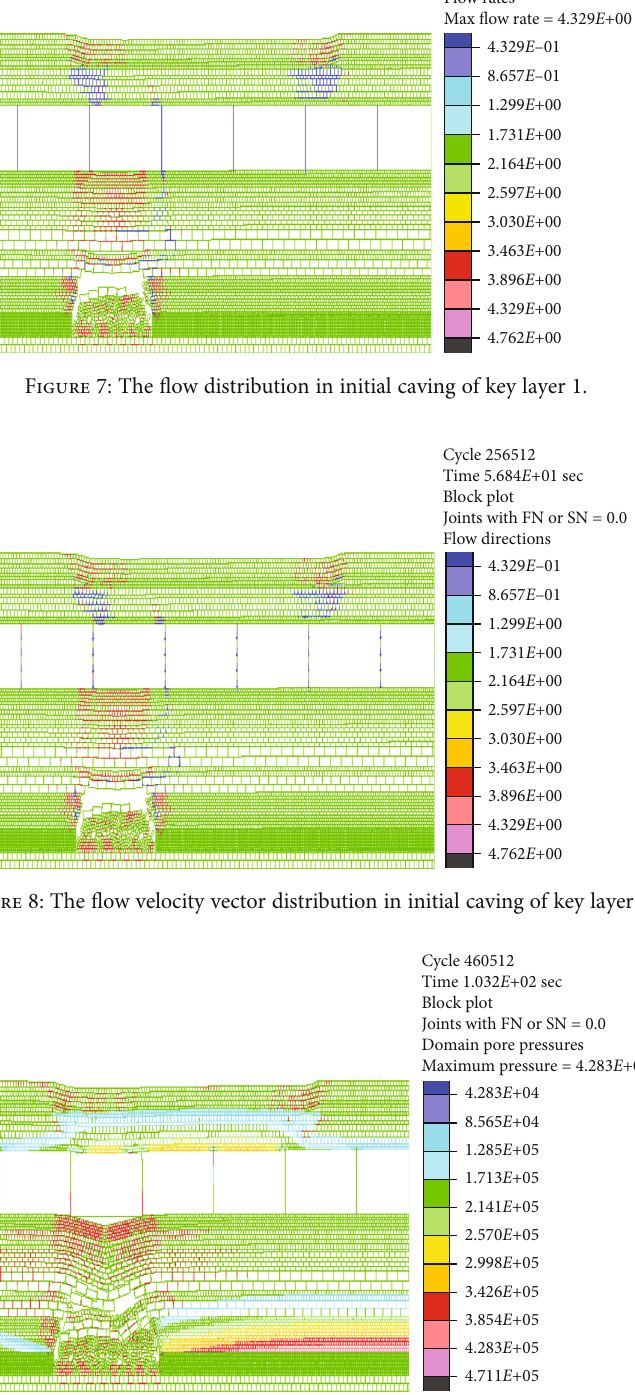
Figure 9: The pore pressure distribution in initial caving of key layer